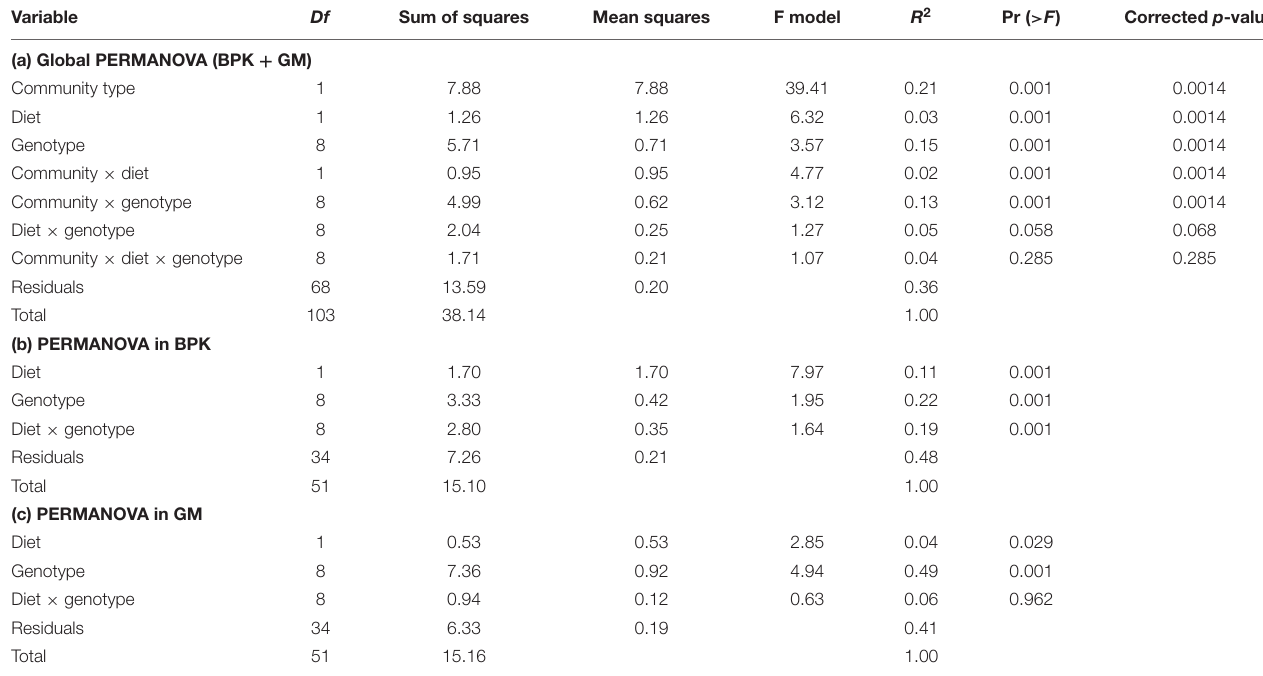
TABLE 1 | Effects of community type, diet, and genotype on the taxonomic composition of microbial communities (Experiment 1).